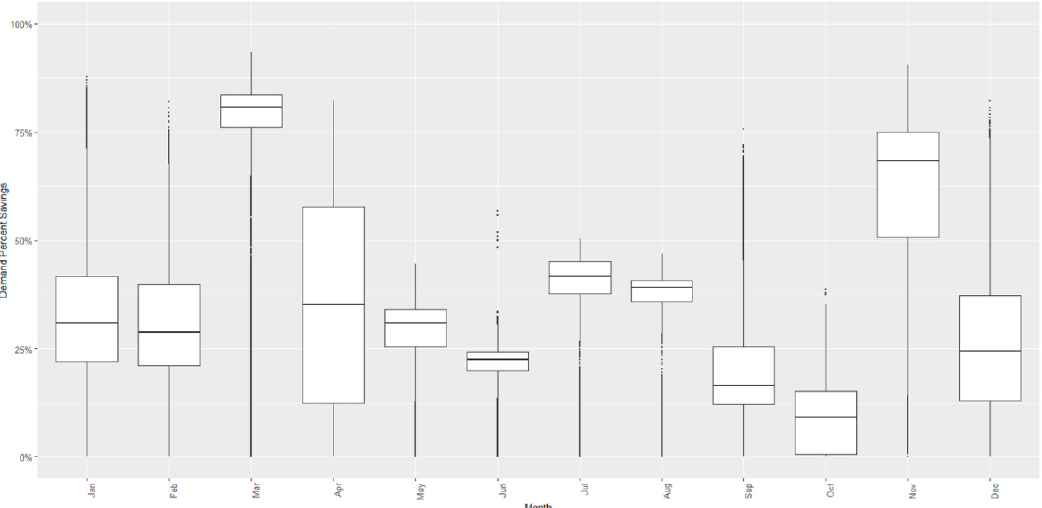
Figure 4. Smart thermostats with utility-signaled 2.2 °C of building pre-conditioning 2 h before peak hour has the potential to save an average of 27% of a building’s demand, but this sample of 101,082 buildings varies from 0–93% by individual building and time of year.